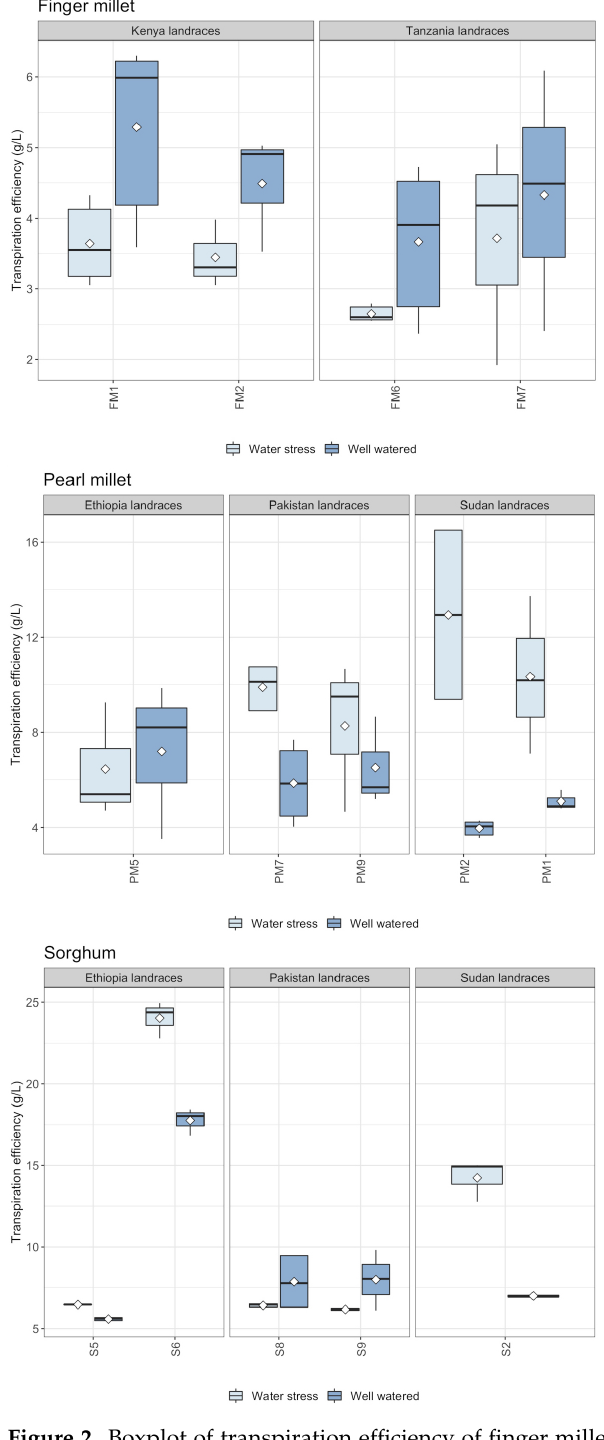
Figure 2. Boxplot of transpiration efficiency of finger millet, pearl millet and sorghum landraces by region of origin. Transpiration efficiency has been evaluated as the ratio between biomass produced/water transpired by the plant. Horizontal bar = median, white diamond = mean, black dots =